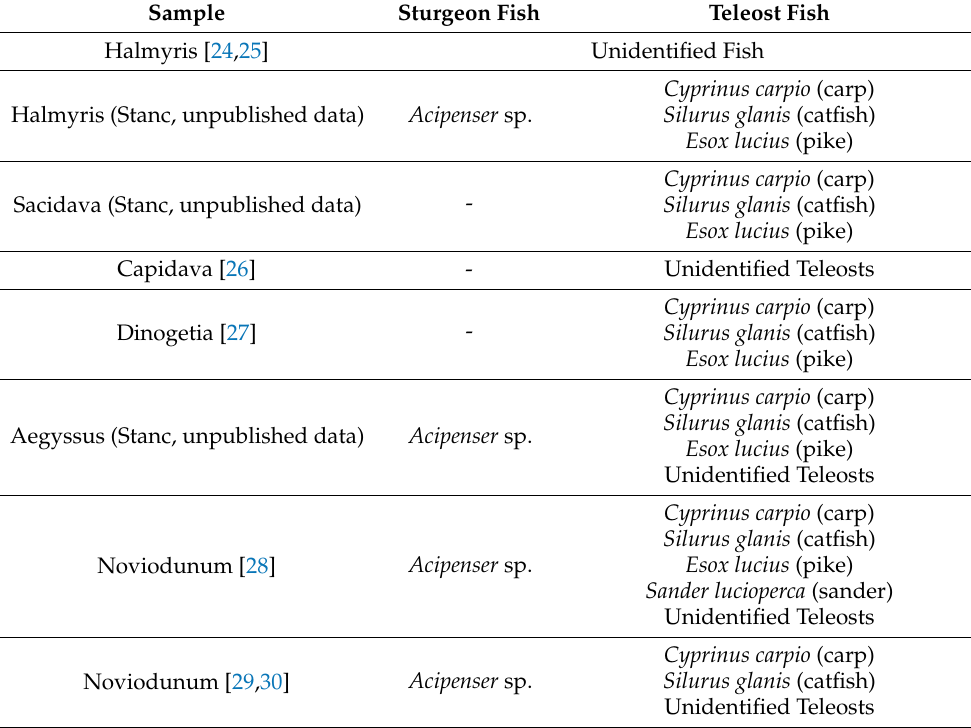
Table 2. Identified fish in Lower Danubian archaeological sites.